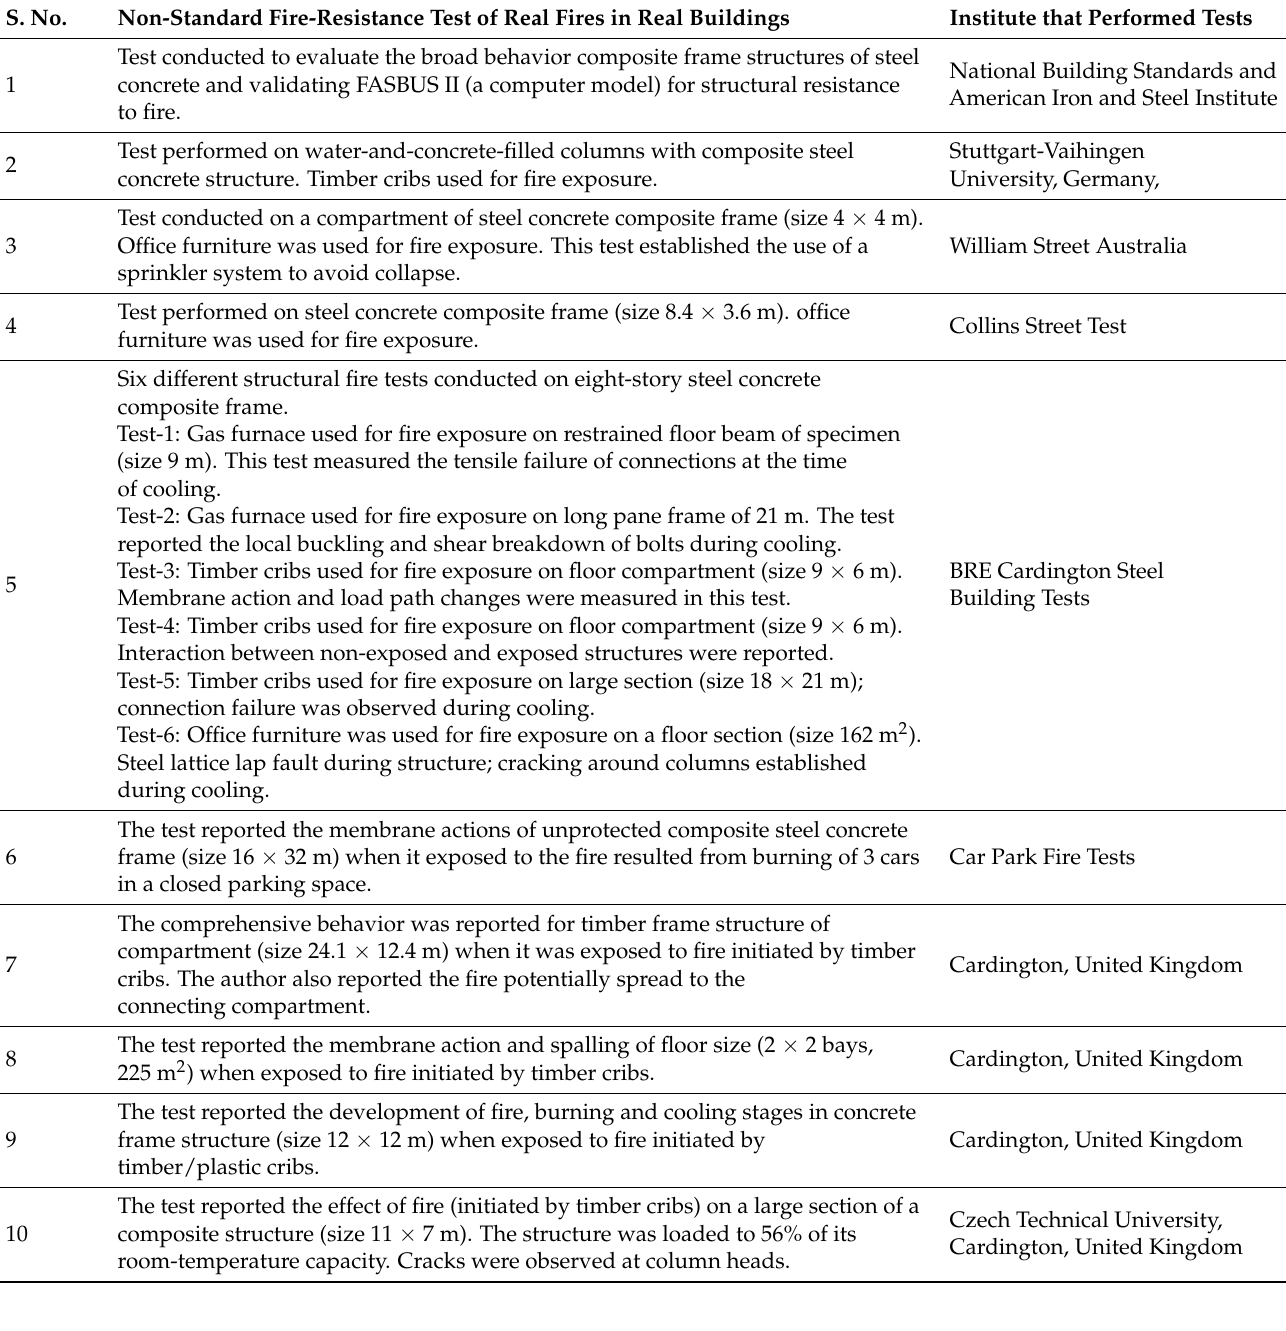
Table 9. Notable non-standard fire-resistance tests of real fires in real buildings